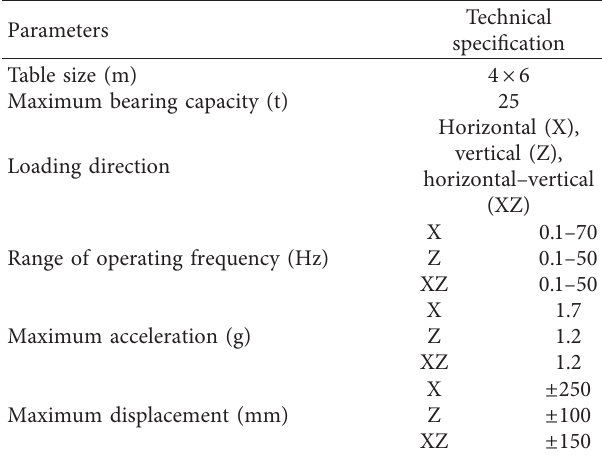
Table 3: Parameters of the shaking table system.